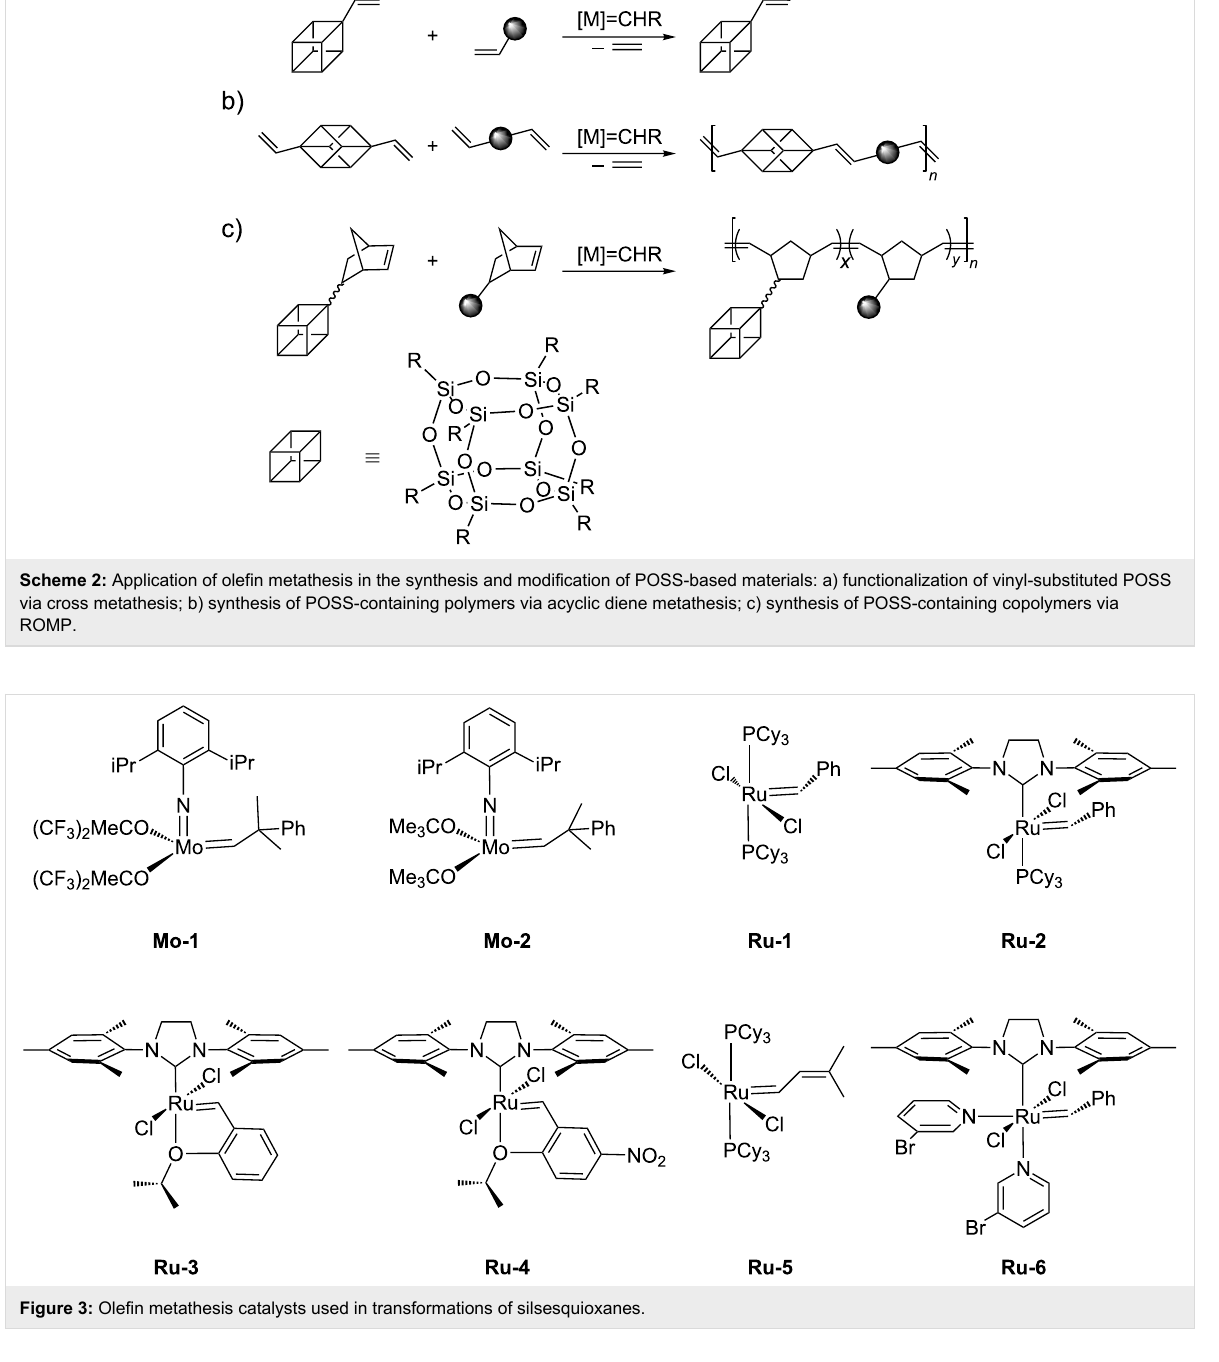
In 2004 Marciniec reported the first efficient cross metathesis of octavinylsilsesquioxane (OVS) occurring in the presence of first generation Grubbs’ catalyst ( Ru-1 , Scheme 3)